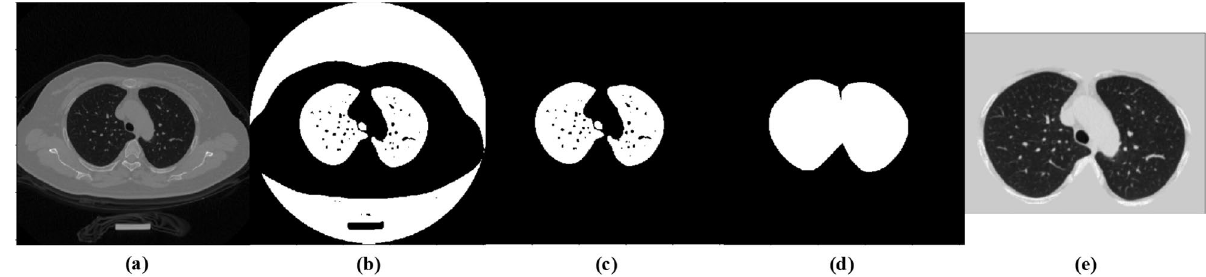
Figure 6. The pre-processing process of the TianChi dataset. ( a ) the raw image, ( b ) the binarized image, ( c ) the extracted original mask, ( d ) the final complete mask, ( e ) the lung parenchyma